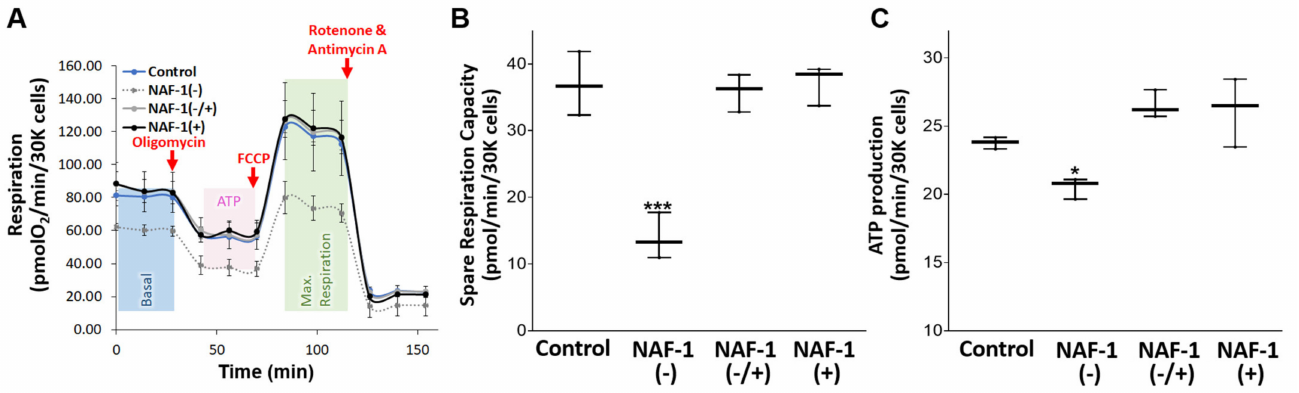
Figure 4. Mitochondrial respiration and ATP production in INS-1E cells with repressed or overexpressed NAF-1 levels. ( A ) Seahorse-generated plots of mitochondrial respiration obtained for the different lines. Data are presented in normalized values. ( B ) Spare respiratory capacity calculated from ( A ). ( C ) ATP levels calculated from ( A ). Results in ( A ) were normalized to the number of cells used (30,000). Data in ( B , C ) are presented as box-and-whisker plots and include all data points measured in three different experiments. * p < 0.05, *** p < 0.001, compared to control; Student’s t -test, N =